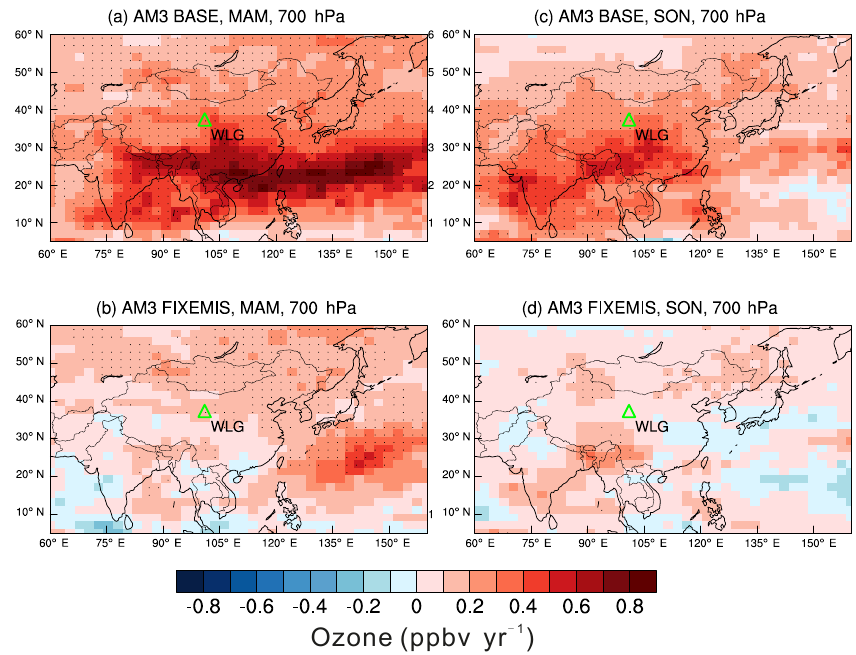
Figure 6. (a–b) The 1995–2014 trends of springtime average ozone sampled at 700hPa as simulated by the GFDL AM3 model with time- varying (BASE) and constant anthropogenic emissions (FIXEMIS). (c–d) Same as (a–b) but for autumn. Triangles denote the location of WLG. Stippling indicates areas where the trend is statistically significant at the 95% confidence level.